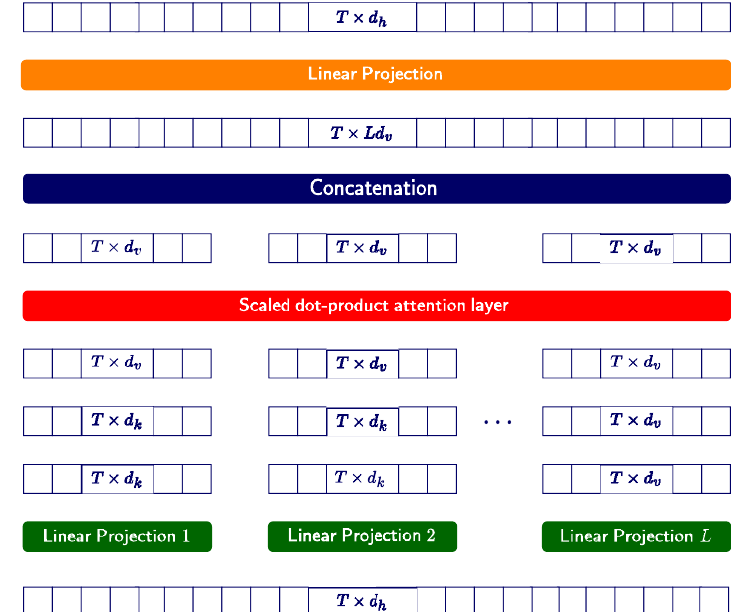
Fig. 5 Architecture of multi-head attention